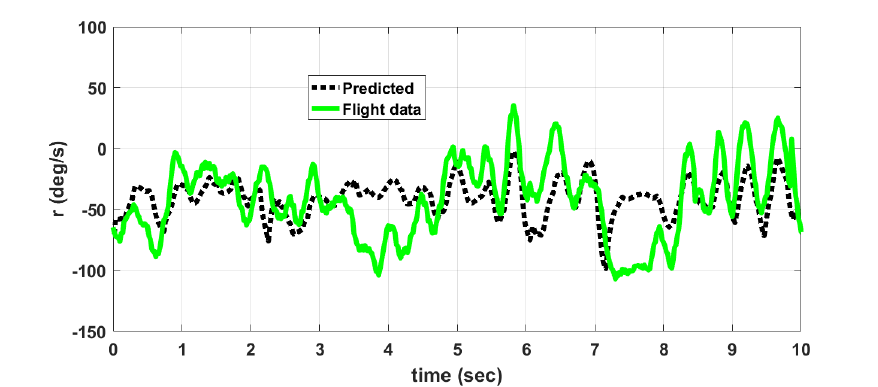
Figure 18. Comparison of angular rate r , predicted by model and flight